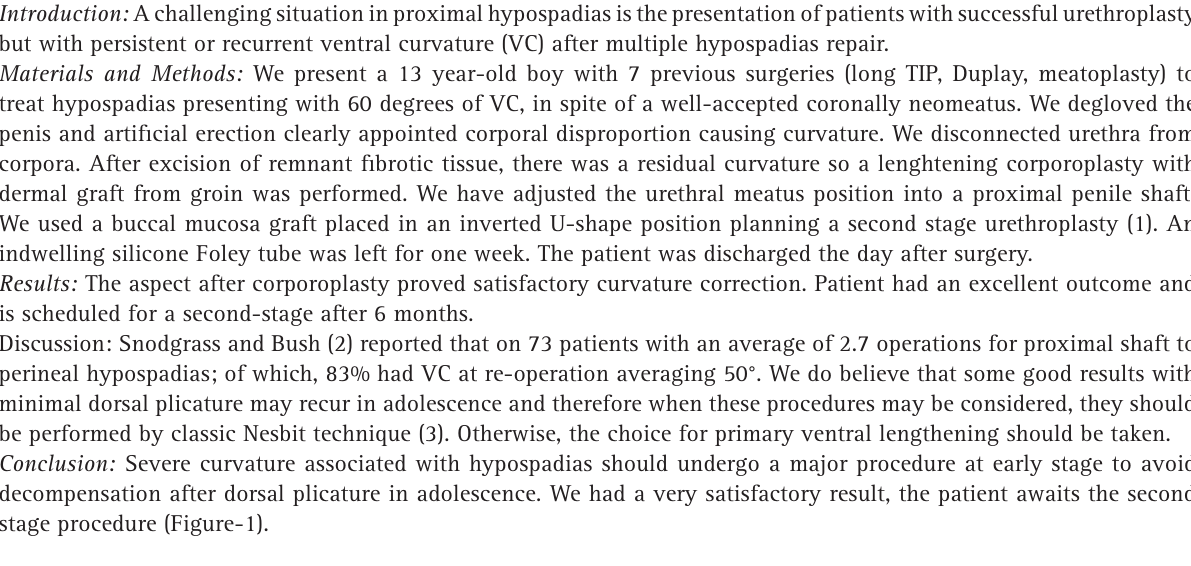
Figure 1 - End aspect after complete healing of buccal mucosa. Notice that penis is straight and second stage will be performed after 6 months of